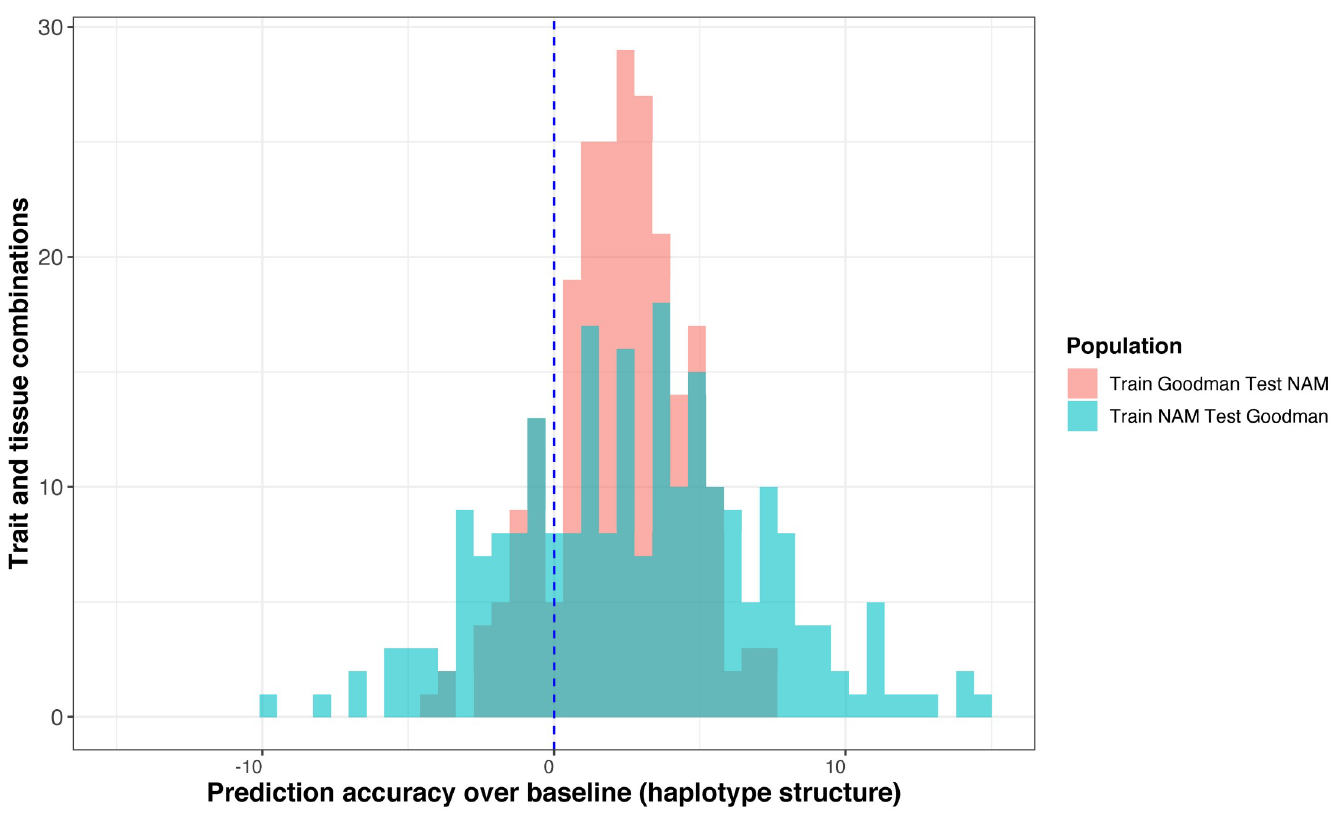
Fig 7. HARE increased prediction accuracy by up to 14% when the model was trained in NAM and tested in the Goodman panel. Summarized differences in prediction accuracy using HARE over the mean accuracy from random HARE (representing haplotype structure) across 26 phenotypes and 7 diverse tissues. The blue dashed line is the mean prediction accuracy using random HARE across each trait and tissue